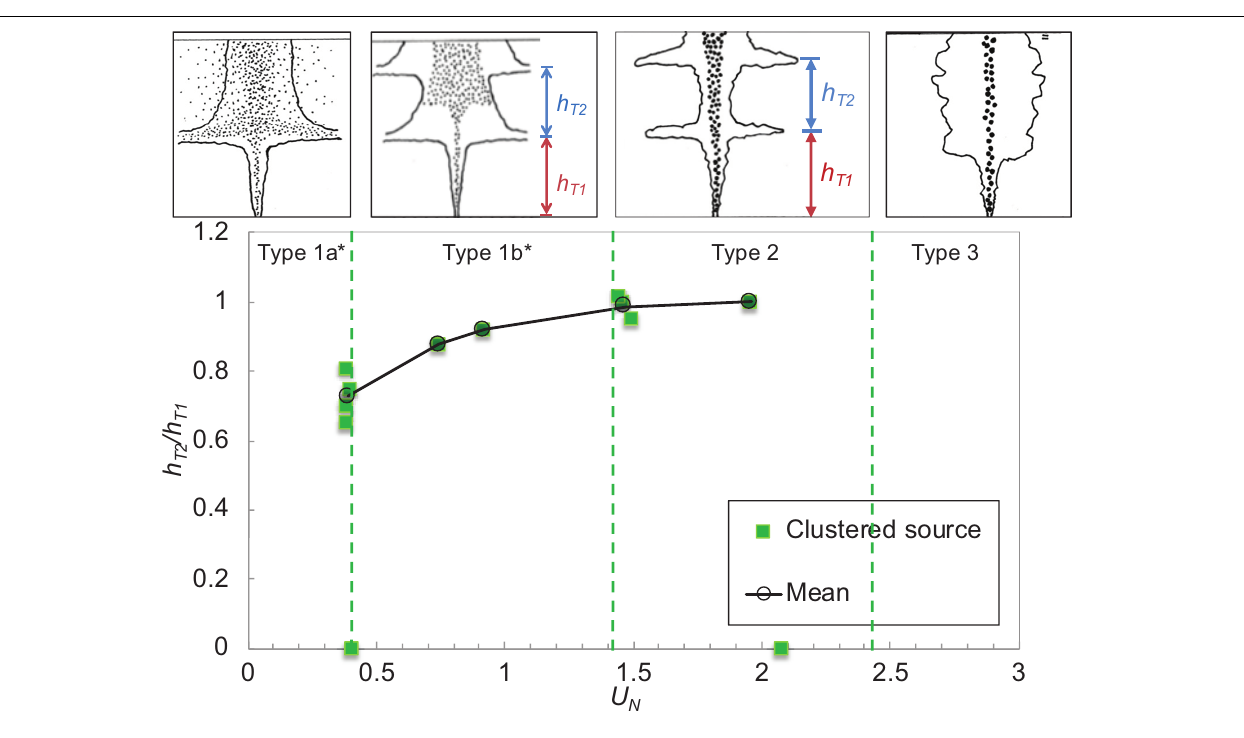
Frontiers in Marine Science | www.frontiersin.org